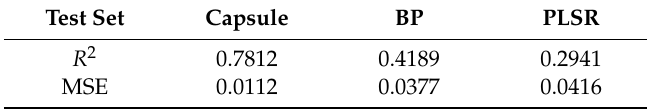
Table 4. Coe ffi cient of determination ( R 2 ) and mean square error (MSE) for the three models: Capsule network, back-propagation algorithm (BP) and partial least square regression (PLSR).